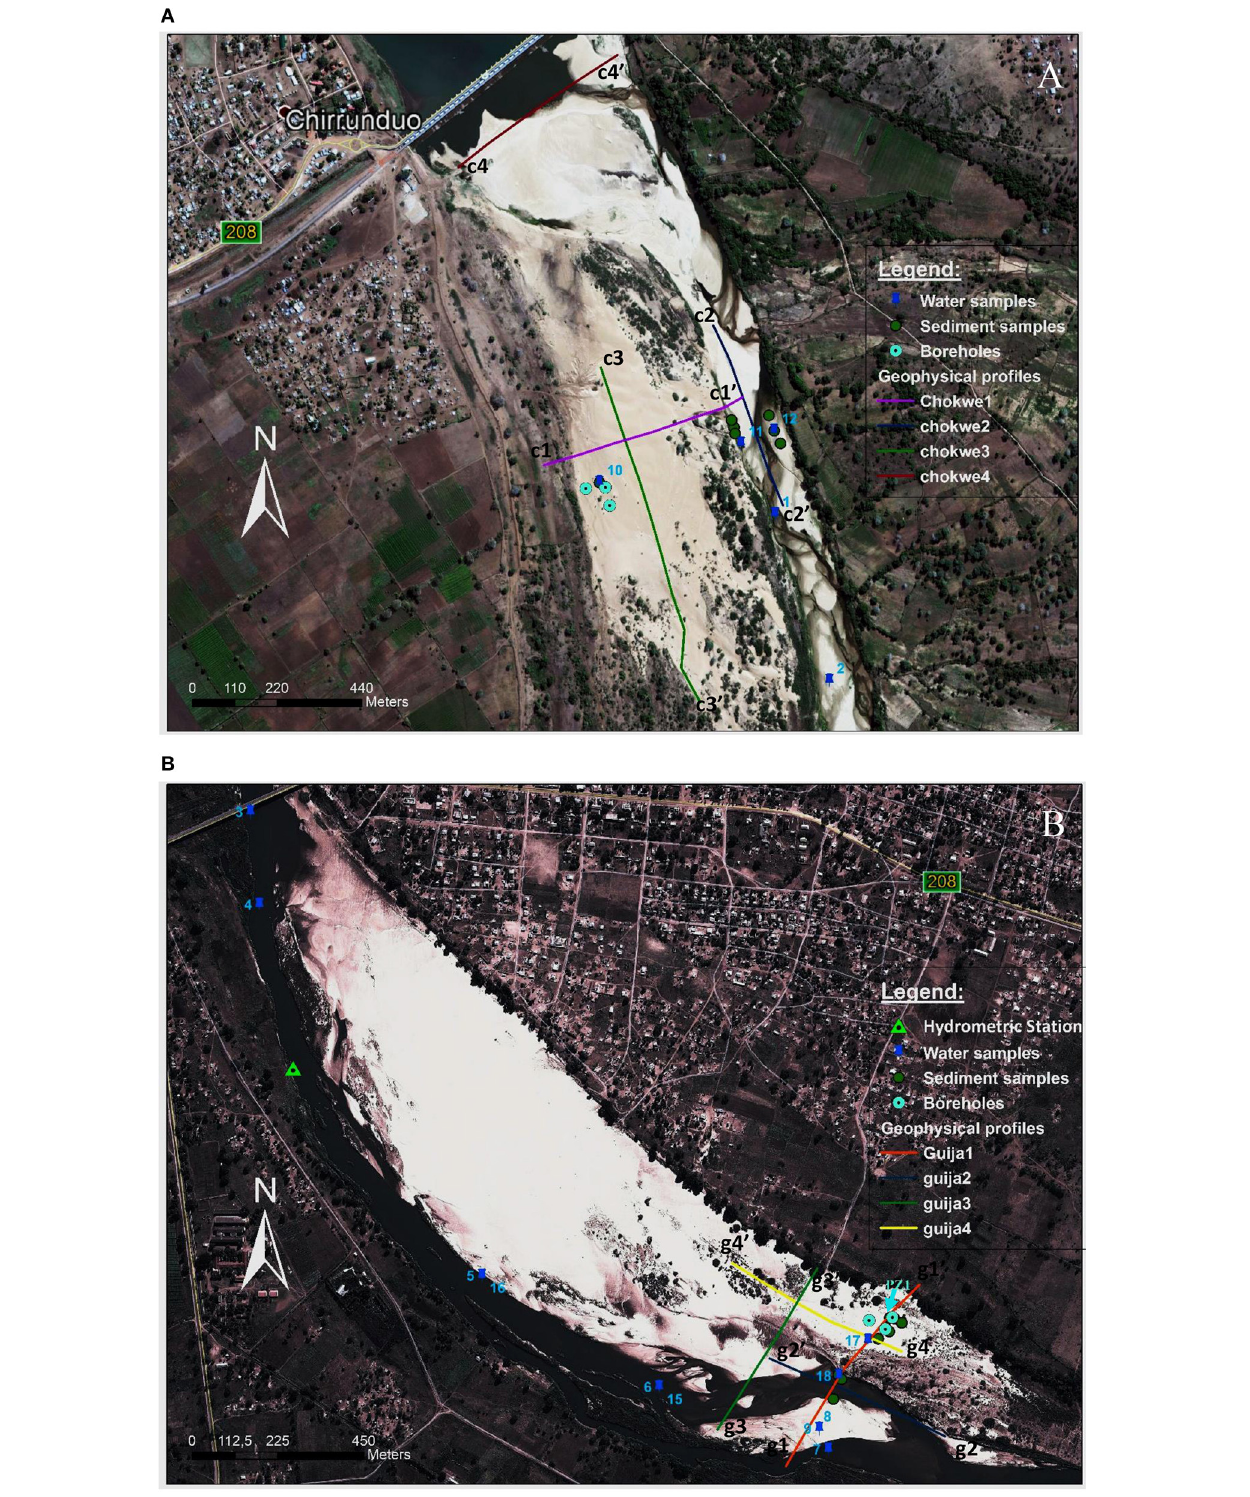
FIGURE 4 | Locations of field investigations in Chókwè (A) and Guijá (B) sites. It includes the geophysical profiles, water samples, sediment samples, boreholes and the location of the hydrometric station. Base map derived from satellite imagery Google Earth pro 2017, Map data: Google, DigitalGlobe 2017.